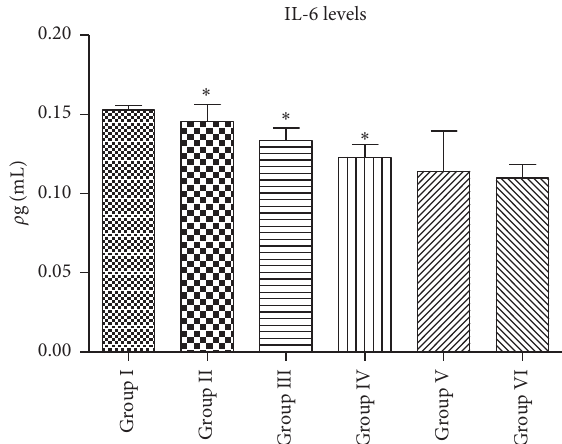
Figure 2: The plasma IL-6 levels (Group I � negative control; Group II � EA200; Group III � EA300; Group IV � EA400; Group V � positive control; and Group VI � normal control; data are presented as mean ± SEM) ∗ p > 0 . 05 vs. Group I; ∗∗ p < 0 . 05 vs. Group